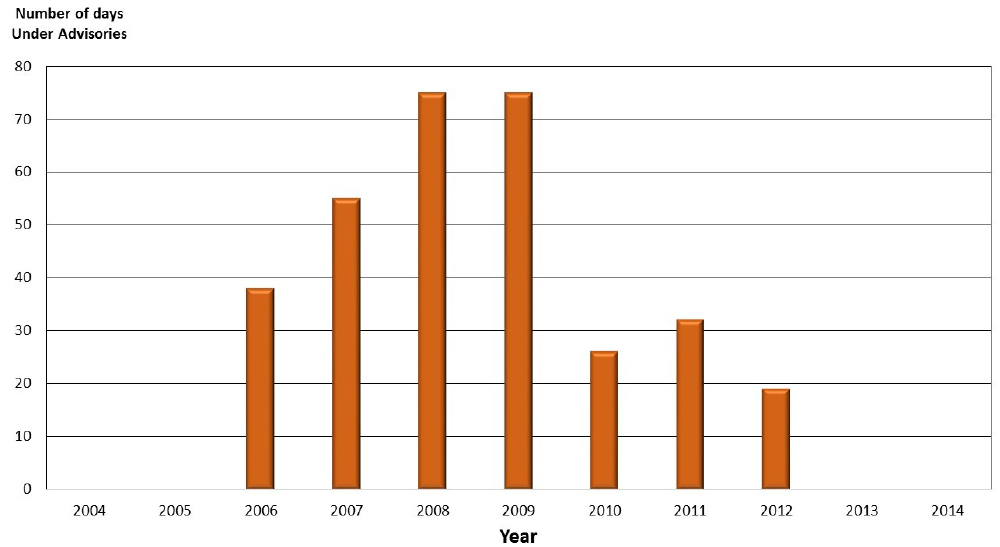
Figure 6. Oregon Department of Environmental Quality’s (ODEQ) harmful cyanobacterial bloom (CyanoHAB) advisories for Lemolo Lake, and the number of days under an advisory. Current (post-2014) data has not been posted on the website: (Available online: http: // www.oregon.gov / oha / ph / HealthyEnvironments / Recreation / HarmfulAlgaeBlooms / Pages / index.aspx; accessed on 28 May 2019). Note: There were no CyanoHAB advisory days for Lemolo Lake in 2004, 2005, 2013, and